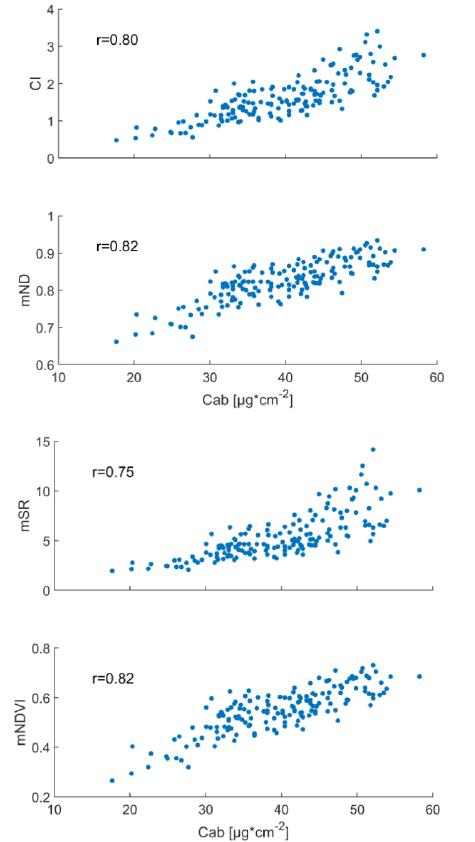
Figure 6: Plot of the different SIs against Chlorophyll content with corresponding correlation coefficient.